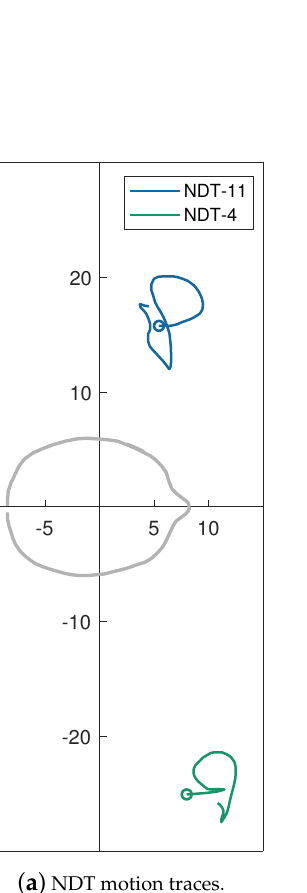
Figure 3. Illustration of the relative brain displacement and strain measures reported through monitoring Neutral Density Targets (NDTs) for the impact C380-T2: A deceleration impulse to the parietal location, offset from anatomical axes with a helmet present (adapted from [36,45,46]). ( a ) Motion of NDT-4 and NDT-11, the targets at the centre of each cluster, presented as co-ordinate traces starting at the location indicated by the circular marker and following the path depicted by line trace. Hardy et al. [36] provide similar traces for all NDTs available in the anatomical plane. ( b ) The response history of the same key NDTs against time for the complete impact duration. The top panel shows the relative displacements of NDT-4 and NDT-11 in the anterior-posterior ( x ) and medial-lateral ( y ) directions. The bottom depicts the corrected mean strains in Cluster 1 (surrounding NDT-4) calculated by Zhou et al. [46] using a tetrahedral (tetra) formation compared to the triad based calculation Zhou et al. [45] and to the values originally reported by Hardy et al. [36] across the same